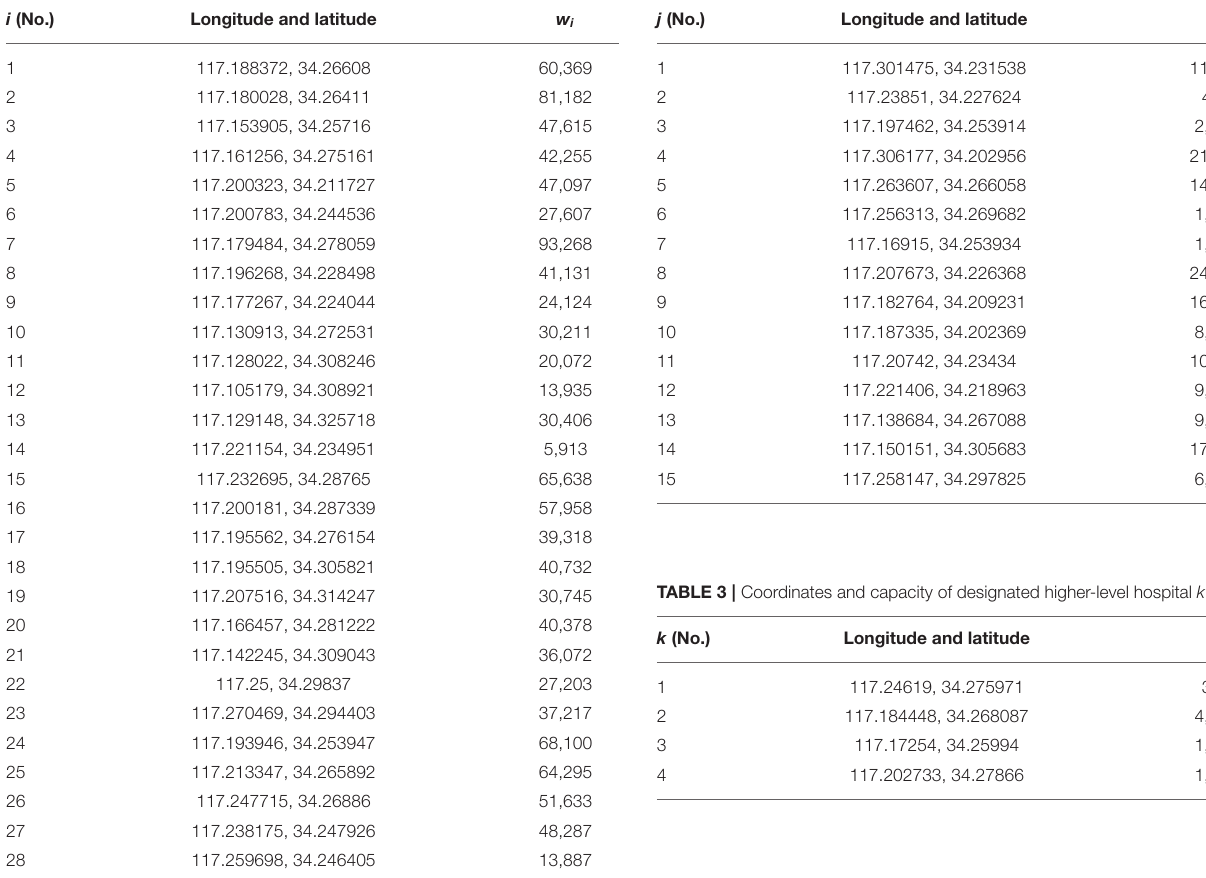
TABLE 1 | Coordinates and number of residents at resident demand node i . TABLE 2 | Coordinates and capacity of candidate Fangcang shelter location j .